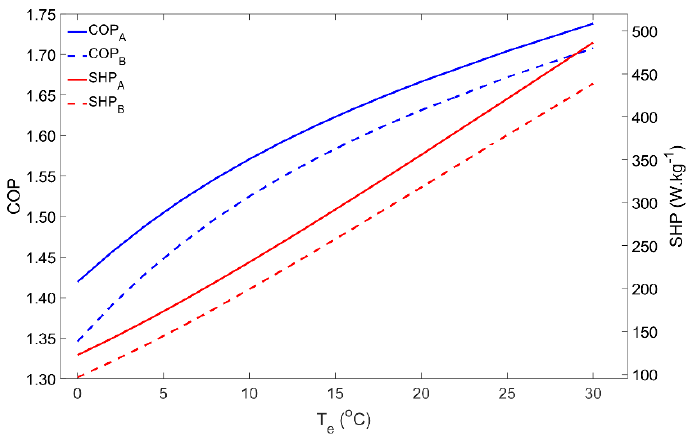
Figure 3. Effect of the evaporator temperature on the adsorber performance for scenarios A and